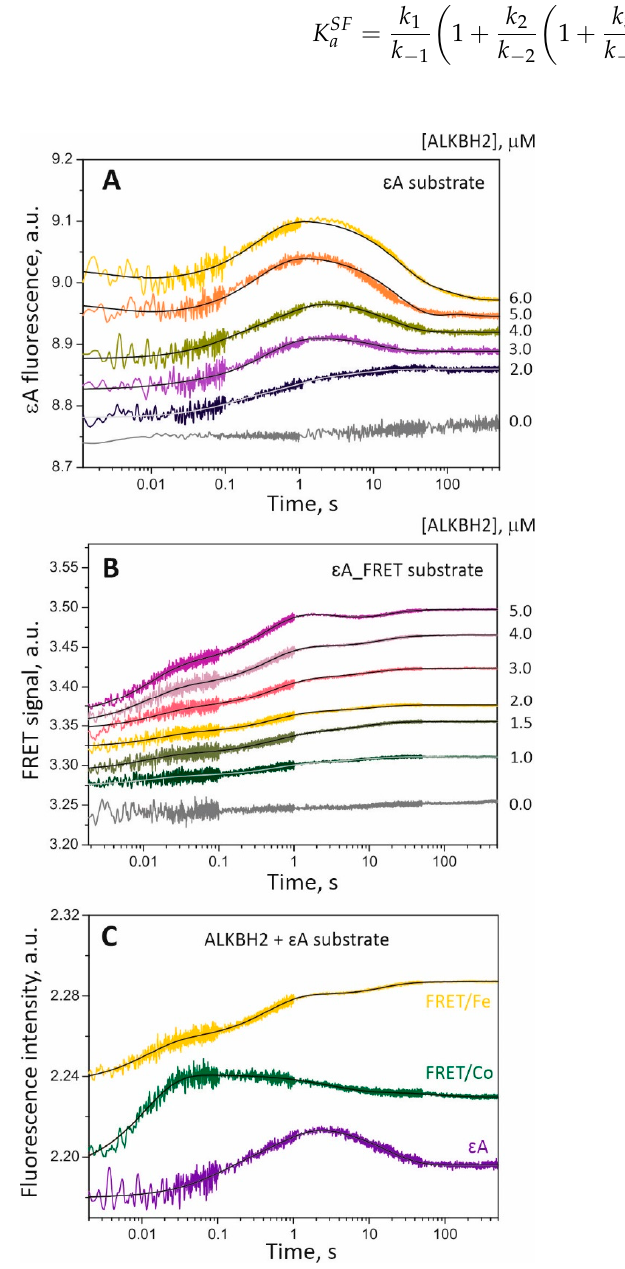
Figure 6. Interactions of ALKBH2 with the ε A-containing dsODN as measured by SF analysis. ( A ) Time courses of the ε A fluorescence intensity obtained for 3 μ M alkylated DNA and various concentrations of the enzyme. ( B ) Time courses of FRET between the fluorophore (FAM) and the quencher (BHQ1) as obtained for 2 μ M ε A-containing dsODN and various concentrations of ALKBH2. ( C ) Time courses of FRET between the fluorophore (FAM) and the quencher (BHQ1) as determined for 1.5 μ M ε A-containing dsODN and various concentrations of ALKBH2. Gray curves represent control experiments where the fluorescent component was mixed with the buffer. For each set of curves, jagged traces represent experimental data. Smoothed curves were built via global fitting of the dataset to Scheme 2.